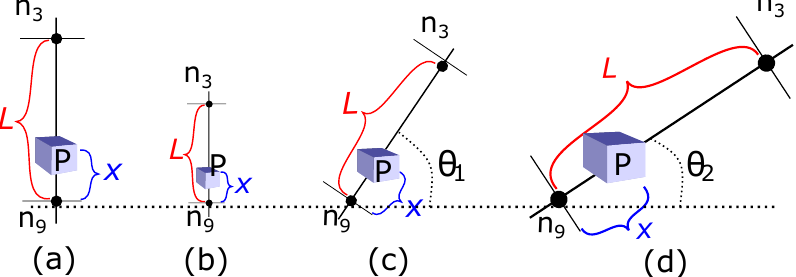
Figure 5. Scale and rotation effects on the T-node map. In all cases, meaningful information can still be shared between robots. ( a ) Original section n 9 n 3 of Figure 4b. ( b ) Figure 5a scaled down. ( c ) Figure 5a rotated by angle θ 1 . ( d ) Figure 5a scaled up and rotated by angle θ 2 .